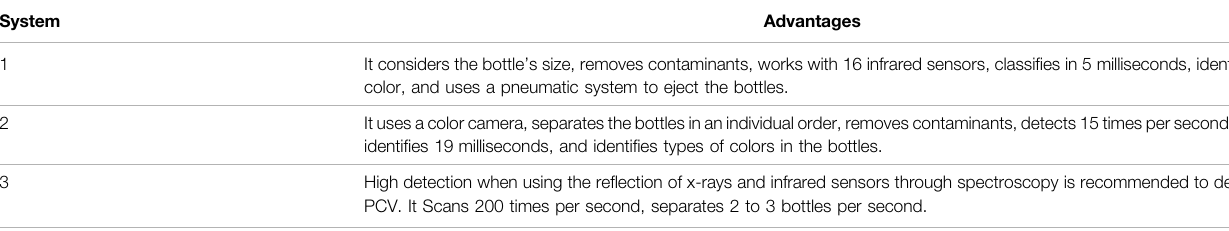
TABLE 5 | Commercial systems for the classi fi cation of different types of recyclable